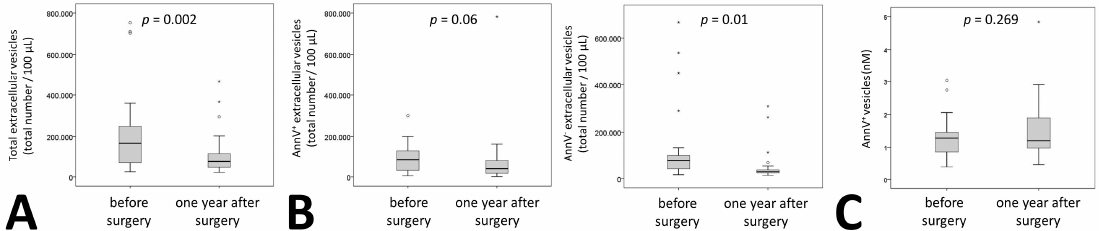
Figure 1. Extracellular vesicle dynamics in patients undergoing bariatric surgery. ( A ) Total medium extracellular vesicle content was determined by flow cytometry analysis in citrated plasma of 27 patients before and one year after surgery. Results are given as total number of extracellular vesicles per 100 µ L plasma. ( B ) Phosphatidylserine positive medium extracellular vesicles in citrated plasma of 27 patients before and one year after surgery were identified by staining with AnnexinV (AnnV), the remaining medium extracellular vesicles were defined as AnnV – . Numbers of positive and negative medium extracellular vesicles were evaluated using flow cytometry. Results are given as total number of extracellular vesicles per 100 µ L plasma. ( C ) Phosphatidylserine positive medium extracellular vesicles were analyzed in 26 patients using an ELISA as indicated under Materials and Methods. Values are given as AnnexinV + extracellular vesicles in nM. For (A–C) a Wilcoxon test was used. p ≤ 0.05 was considered significant.